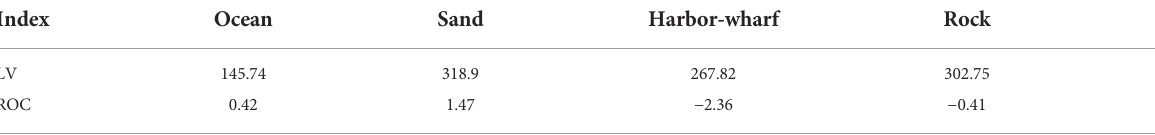
TABLE 3 LV and ROC of each coastal feature.